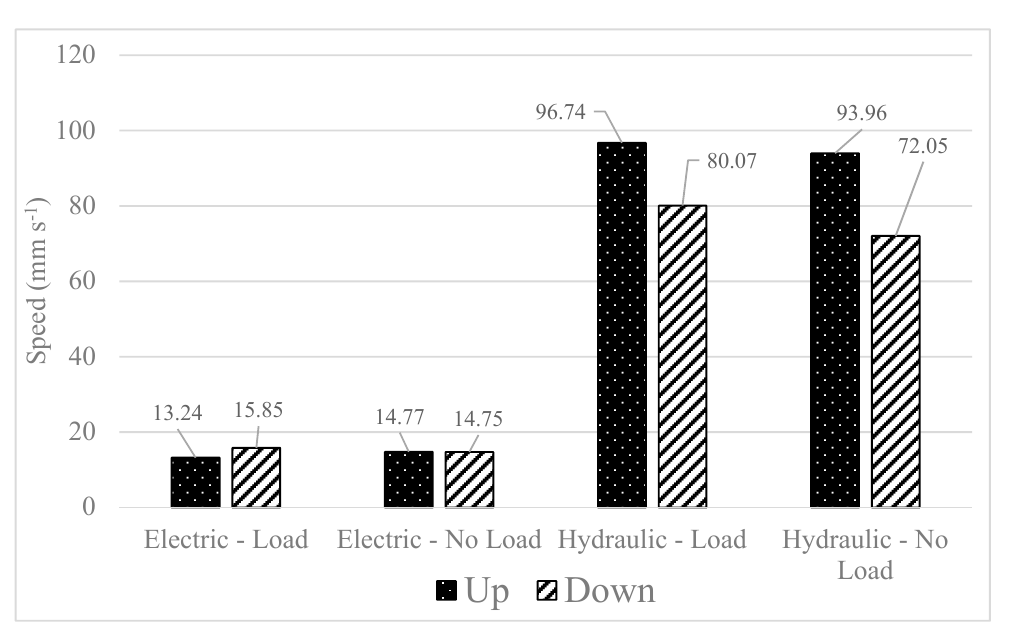
Figure 7. Operational speeds for the electric and hydraulic actuators, moving up and down, both under and without load with numbers presented within the plot showing the mean